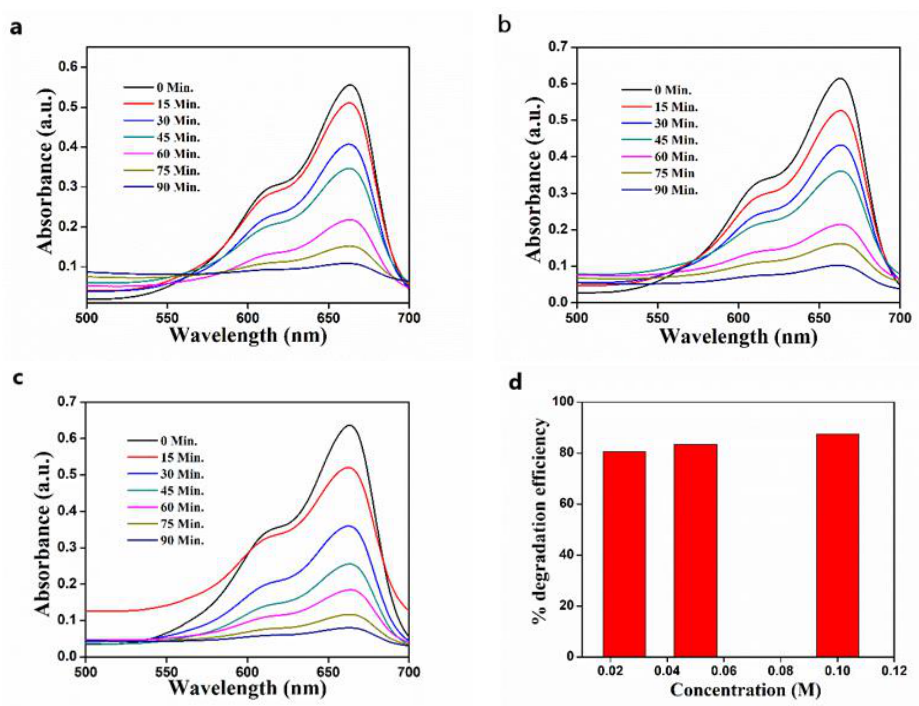
Figure 12. The photocatalytic degradation of MB after treatment with ZnO synthesized from ( a ) 0.025 M Zn(NO 3 ) 2 ; ( b ) 0.05 M Zn(NO 3 ) 2 ; ( c ) 0.1 M Zn(NO 3 ) 2 ; ( d ) the effect of Zn(NO 3 ) 2 · 6H 2 O concentration on photodegradation of MB.